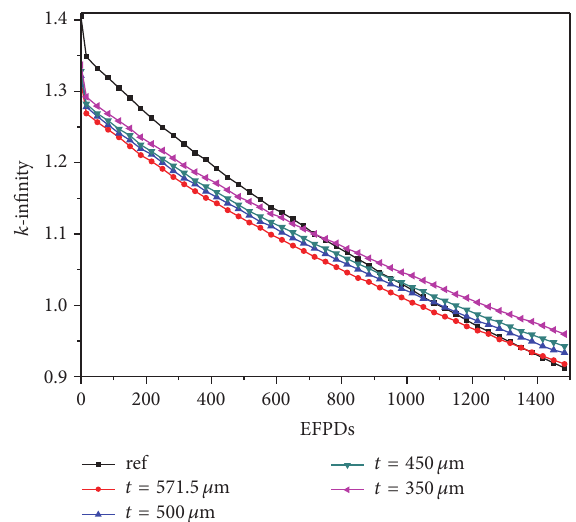
Figure 3: 𝑘 -infinity versus EFPDs for 4.9% enriched